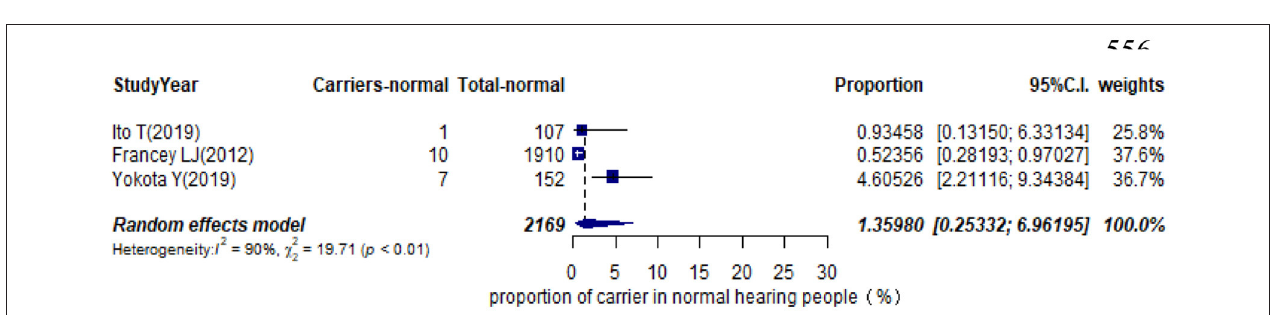
FIGURE 5 | Prevalence of carrier STRC mutation in normal hearing